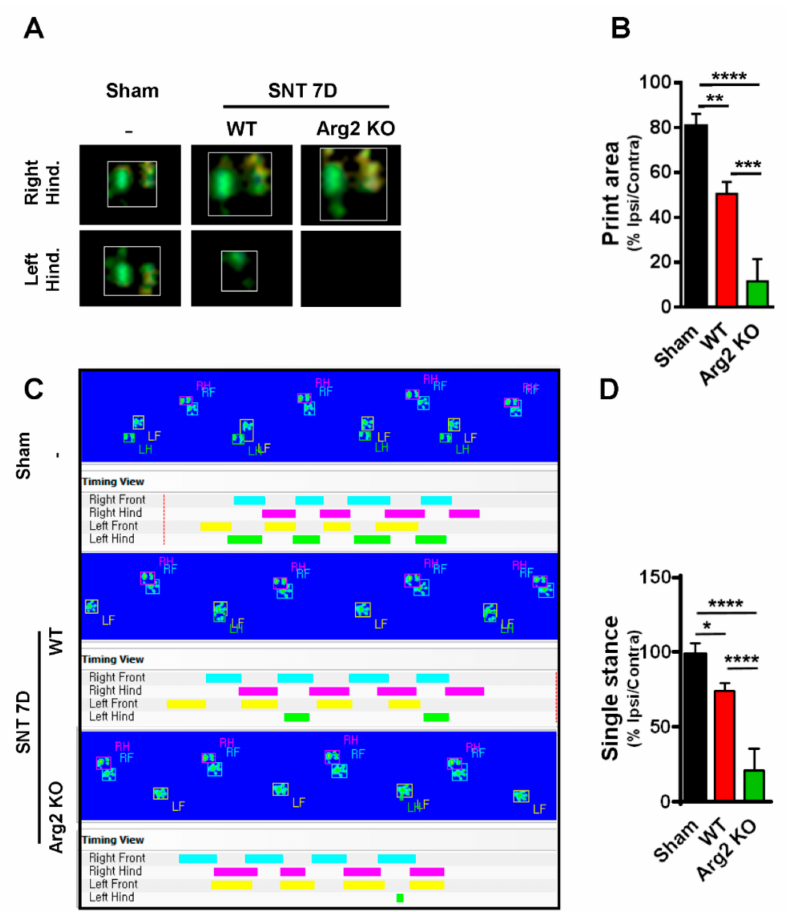
Figure 2. Representative images obtained in the CatWalk analysis on day 7 post-surgery. ( A ) Images of the footprint area of both left and right hind paws of mice. ( B ) Quantitative data for the footprint area compared among the three groups. ( C ) The single stance parameter measured by the duration time of a single hind paw touching the glass plate (ratio of length of green / pink bar). ( D ) Quantitative data for single stance parameter analysis compared among the three groups. ( B , D ) Sham ( n = 3), WT ( n = 4), and Arg2 KO ( n = 3). Data are presented as means ± SEM (one-way ANOVA with Tukey’s post hoc test, F (2,13) = 56.23, F (2, 18) = 31.56, **** p < 0.0001, *** p < 0.001, ** p < 0.01, and * p < 0.05 versus